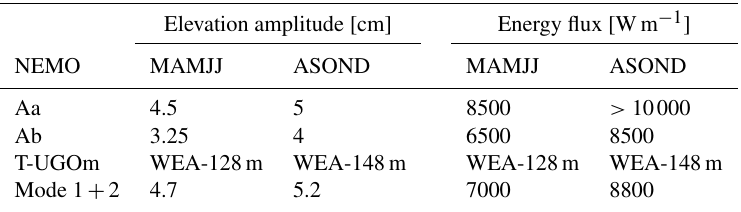
Figure 7. Baroclinic modal structures for the three first modes (left panels) and simulated amplitude of baroclinic surface elevation for the five first modes (right panel) for all the typical density profiles of the Bay of Biscay. The vertical modal structures are different for vertical processes ( w and η , upper left panels) and horizontal ones ( u , v and P , lower left panels). The black points show the extrema of the modes. The simulations are sorted with respect to the seasons. On the right panels, the white line represents the sum of the baroclinic modes and the colored patches represent the modal contribution to the complex sum: if the patch of mode n is located on top of the sum line, then mode n works against mode n − 1. Table 3. Baroclinic elevation amplitude and vertically integrated energy flux near the IT generation zone. The NEMO simulation is compared throughout two seasons: from March to July (MAMJJ) and from August to December (ASOND). MAMJJ stratification is close to the WEA- 128m one and ASOND stratification is close to the WEA-128m one. NEMO values have been extracted on two generation zones near 1 ◦ N, 45.8 ◦ W (Aa and Ab in Tchilibou et al.,